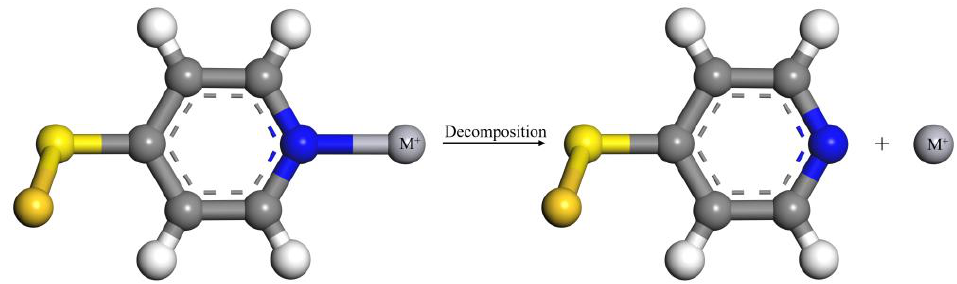
Figure 5. A model for the decomposition reaction of metal ions and pyridine complex(M-Py).